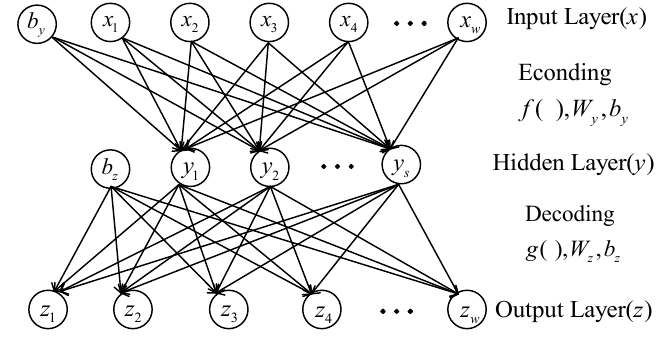
Figure 1. Flow chart of the proposed method. CNN: convolutional neural network, PolSAR: polarimetric synthetic aperture radar, S-SAE: stacked sparse auto-encoder.